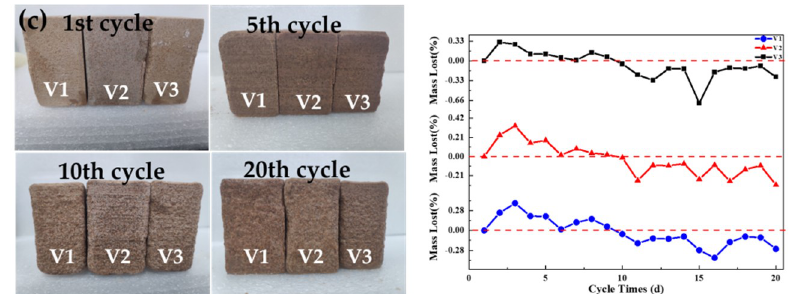
Figure S2: Effect of factors in different levels on difference crystal form, (1) is aragonite, and (2) is vaterite, Table S1: Orthogonal factor and level table, Table S2: L9 (3 4 ) Orthogonal array, Table S3: L9 (3 4 ) Orthogonal designed table and its results, Table S4: Range analysis of the evaluation indexes Aragonite mole fractions, Table S5: Range analysis of the evaluation indexes Vaterite mole